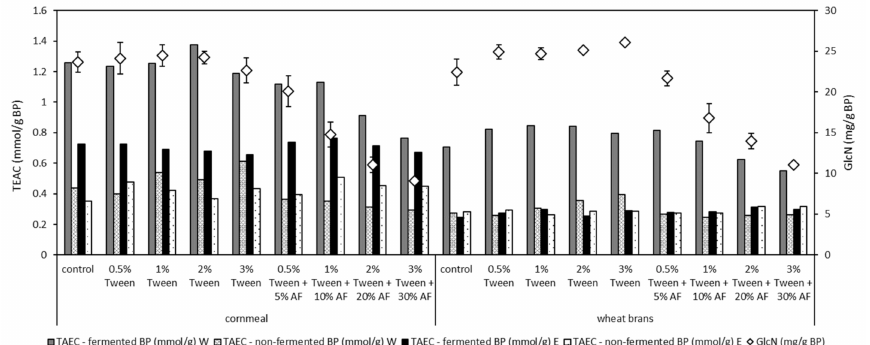
Figure 2. Yields of glucosamine (GlcN) in mg/g of fermented bioproducts and antioxidant activity (TEAC) expressed as Trolox equivalent in mmol/g of dried SSF bioproduct. W—water leachates, E—ethanol leachates, AF—animal fat by-product. Error bars showed a standard deviation, α =